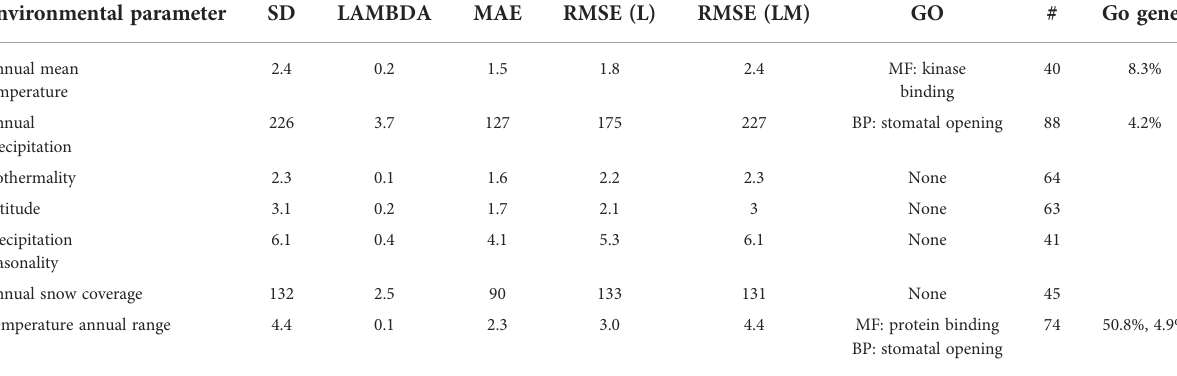
TABLE 2 A summary of the results of best preforming least absolute shrinkage and selection operator (LASSO) model and gene ontology (GO) functional enrichment analysis for the most signi fi cant single nucleotide polymorphisms (SNPs). Environmental